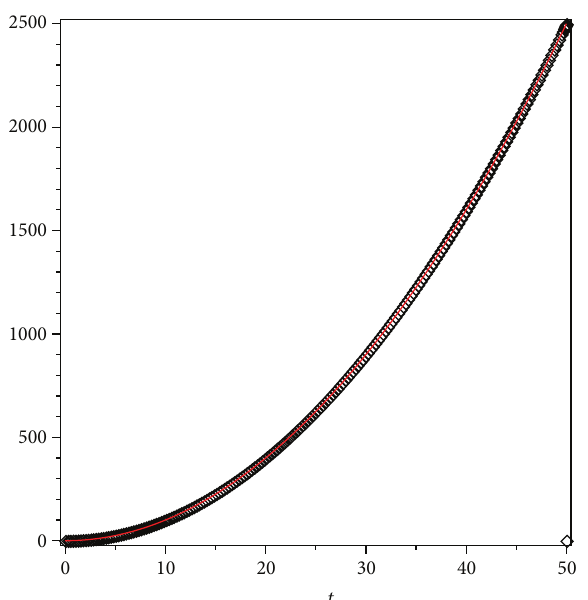
Figure 6: Chebyshev wavelet finite difference solutions for 𝛽 = 1 and different values of 𝛼 for Example